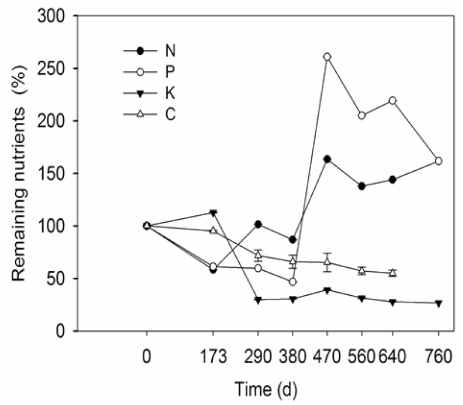
Figure 3. Leaf litter nutrient change during decomposition. Values are means +SE ( n = 3